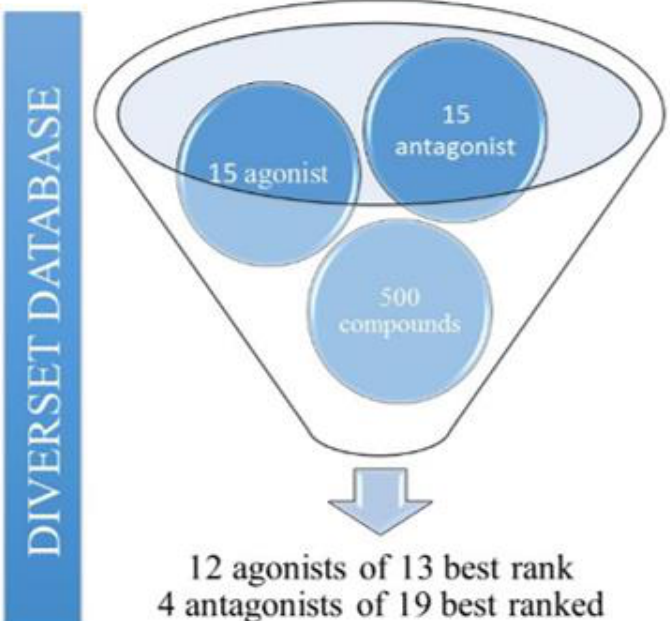
Figure 3. Evaluation of the pharmacophore model selected.